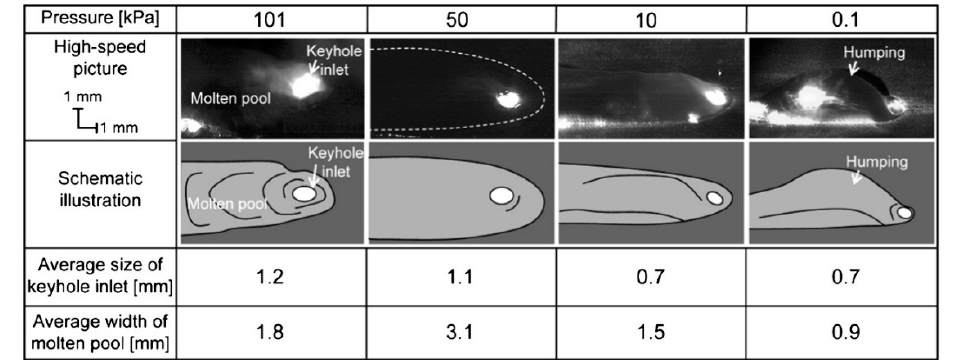
Figure 9. High speed video picture of keyhole inlet and molten pool in type 304 stainless steel weld observed under each reduced pressure(laser power is 16 kW, welding speed is 1 m/min, defocus distance is 0 mm). Reproduced with permission from [44], Taylor & Francis, 2014.